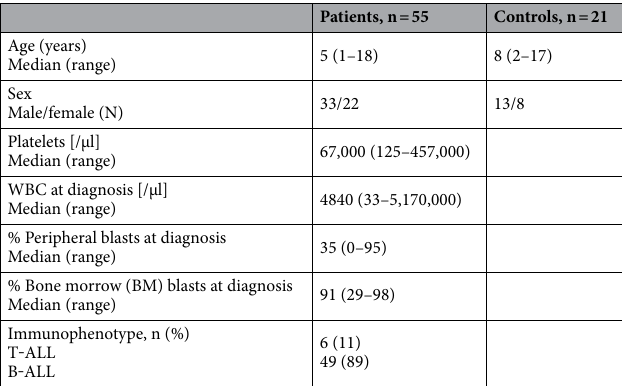
Table 5. Baseline characteristics of the study